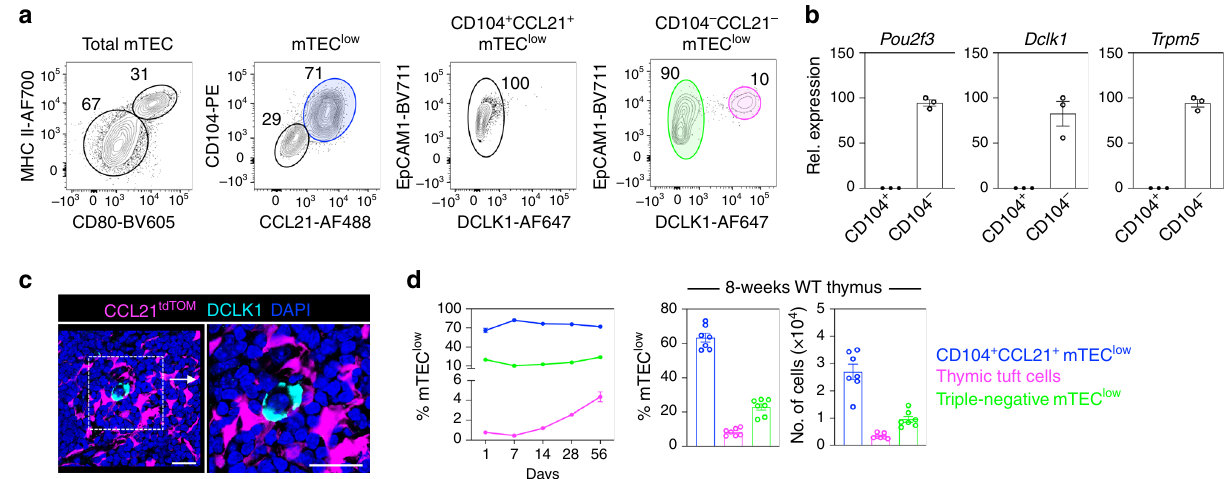
Fig. 1 The adult mTEC low compartment is phenotypically diverse. a EpCAM1 + Ly51 − UEA1 + total mTECs from digested adult C57/BL6 (WT) thymus were subdivided into mTEC low and mTEC hi on the basis of MHCII and CD80 expression. Cell surface (CD104) and intracellular (DCLK1 and CCL21) expression within total mTEC low is shown, which identi fi es three mTEC low subsets: CD104 + CCL21 + cells (blue), CD104 − CCL21 − DCLK1 + thymic tuft cells (magenta) and CD104 − CCL21 − DCLK1 − ‘ triple-negative ’ cells (green). b qPCR analysis showing mRNA levels of the tuft cell signature genes Pou2f3 , Dclk1 and Trpm5 in CD104 + and CD104 − mTEC low subsets that were FACS sorted from WT adult thymus, data are representative of three biological sorts. c Confocal microscopy of frozen tissue sections of adult CCL21 tdTOM thymus stained with antibodies to DCLK1 (cyan), representative of n = 3 independent biological samples. Counterstaining with DAPI is in blue, CCL21 tdTOM is in magenta and scale bars denote 20 μ m. d Analysis of the ontogenetic frequency of mTEC low subsets identi fi ed in a , WT mice of 1 day, 1 week, 2 week, 4 week and 8 week were analysed, CD104 + CCL21 + cells: 1 day n = 10, 1 week n = 10, 2 week n = 7, 4 week n = 7, 8 week n = 6, tuft cells: 1 day n = 9, 1 week n = 9, 2 week n = 6, 4 week n = 7, 8 week n = 10, triple-negative cells: 1 day n =